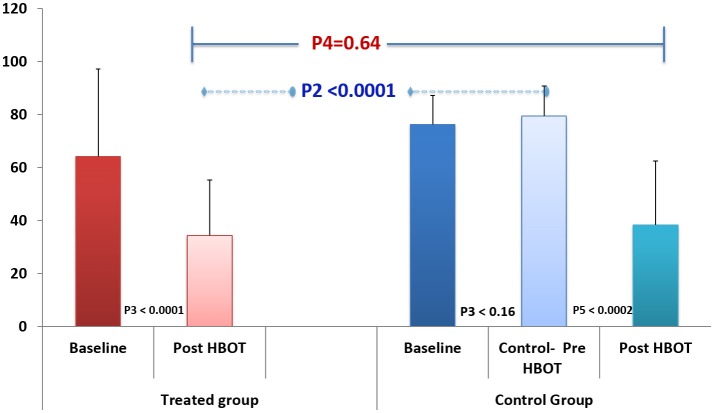
The effect of HBOT on Fibromyalgia impact questionnaire (FIQ).